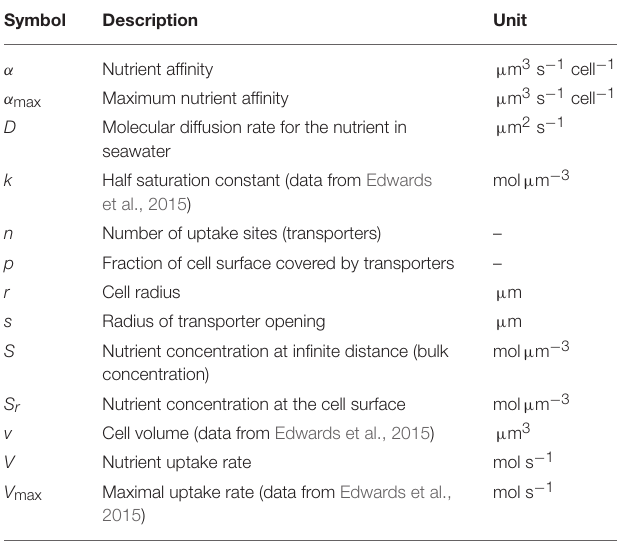
TABLE 1 | Explanation to symbols used in the text. Symbol